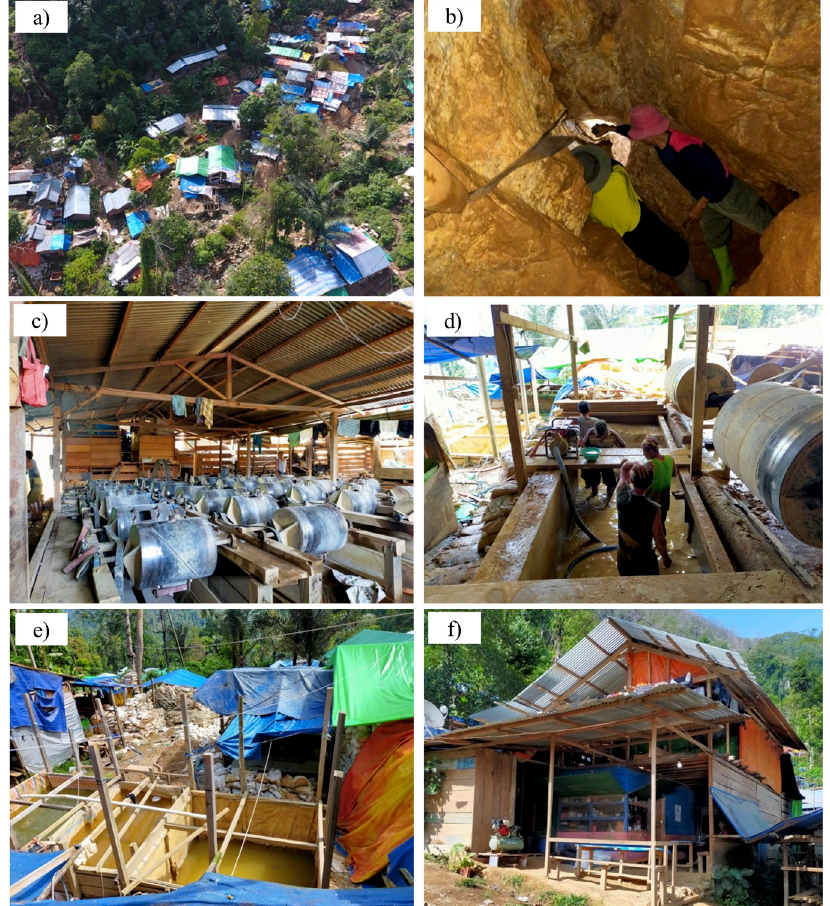
Figure 7. Motomboto ASGM camp. ( a ) Settlements in Motomboto ASGM 3 taken by an unmanned aerial vehicle. ( b ) An active mine hole. ( c ) Trommels for milling materials mined from holes. ( d ) A pool of water mixed with hydrogen peroxide for immersing the milled materials. ( e ) A pool of mercury mixed with cyanide for immersing the materials. ( f ) A common settlement where incoming miners and their families stay and manage a grocery